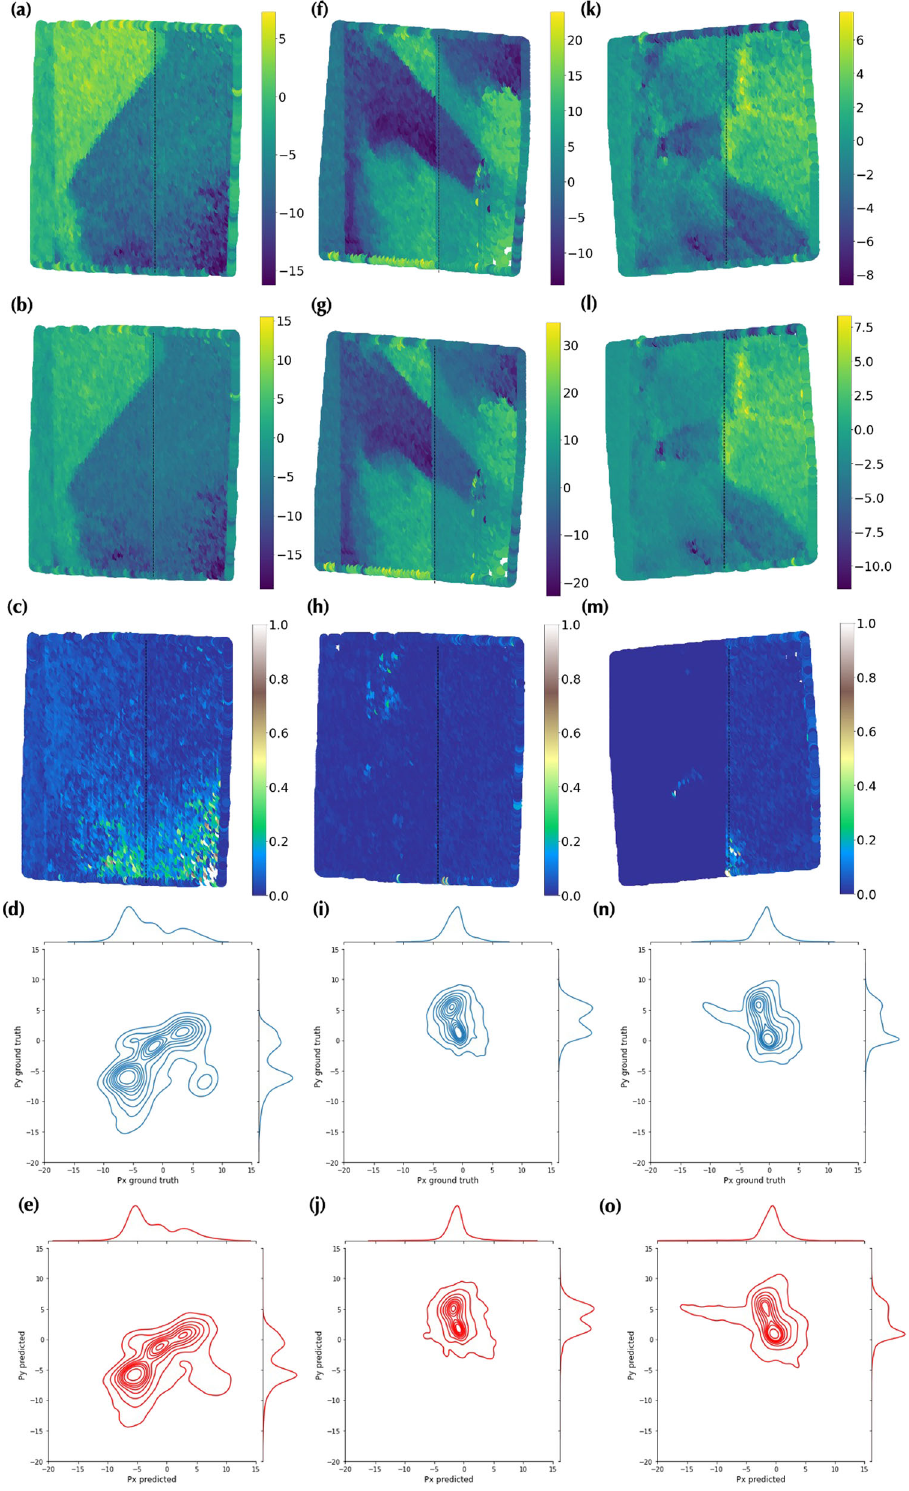
Fig. 4 Polarization maps for various Sm-doped BFO. Polarization maps (using NC) representing the ground truth (top row), prediction (middle row), the 2D histograms for the ground truth and prediction of P x and P y components (last two bottom rows) are shown for 0% ( a – e ), 7% ( f – j ), and 10% ( k – o ) Sm-doped BFO, respectively. Predictions obtained using three different networks as trained on 2/3 of the full stack of sub-images (for every concentration) and tested on the rest. Vertical line in plots refer to the train-test